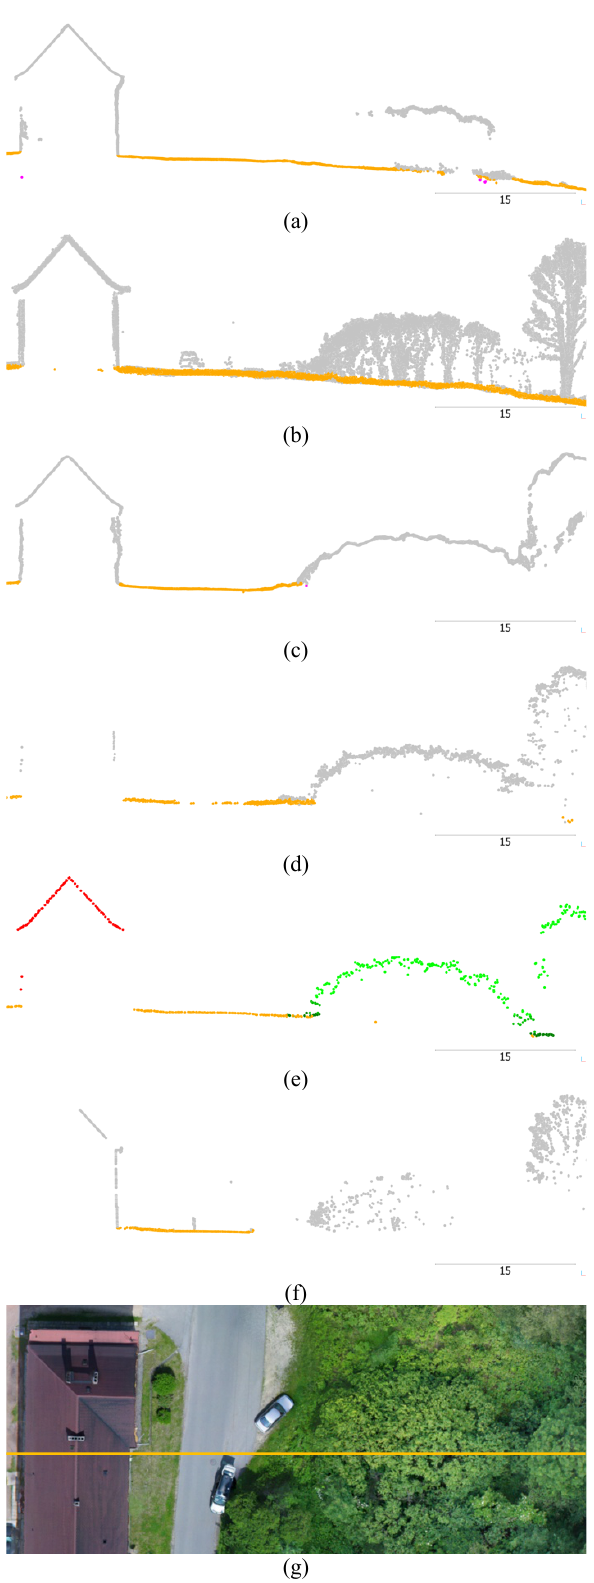
Figure 7 . Vertical cross-sections with thickness of 0.5 m created for (a) photogrammetric data – March 2018, (b) ULS data – March 2018, (c) photogrammetric data – June 2019, (d) ULS data – March 2018, (e) ALS data – summer 2011, (f) TLS data – July 2019, (g) the cross-section placement.